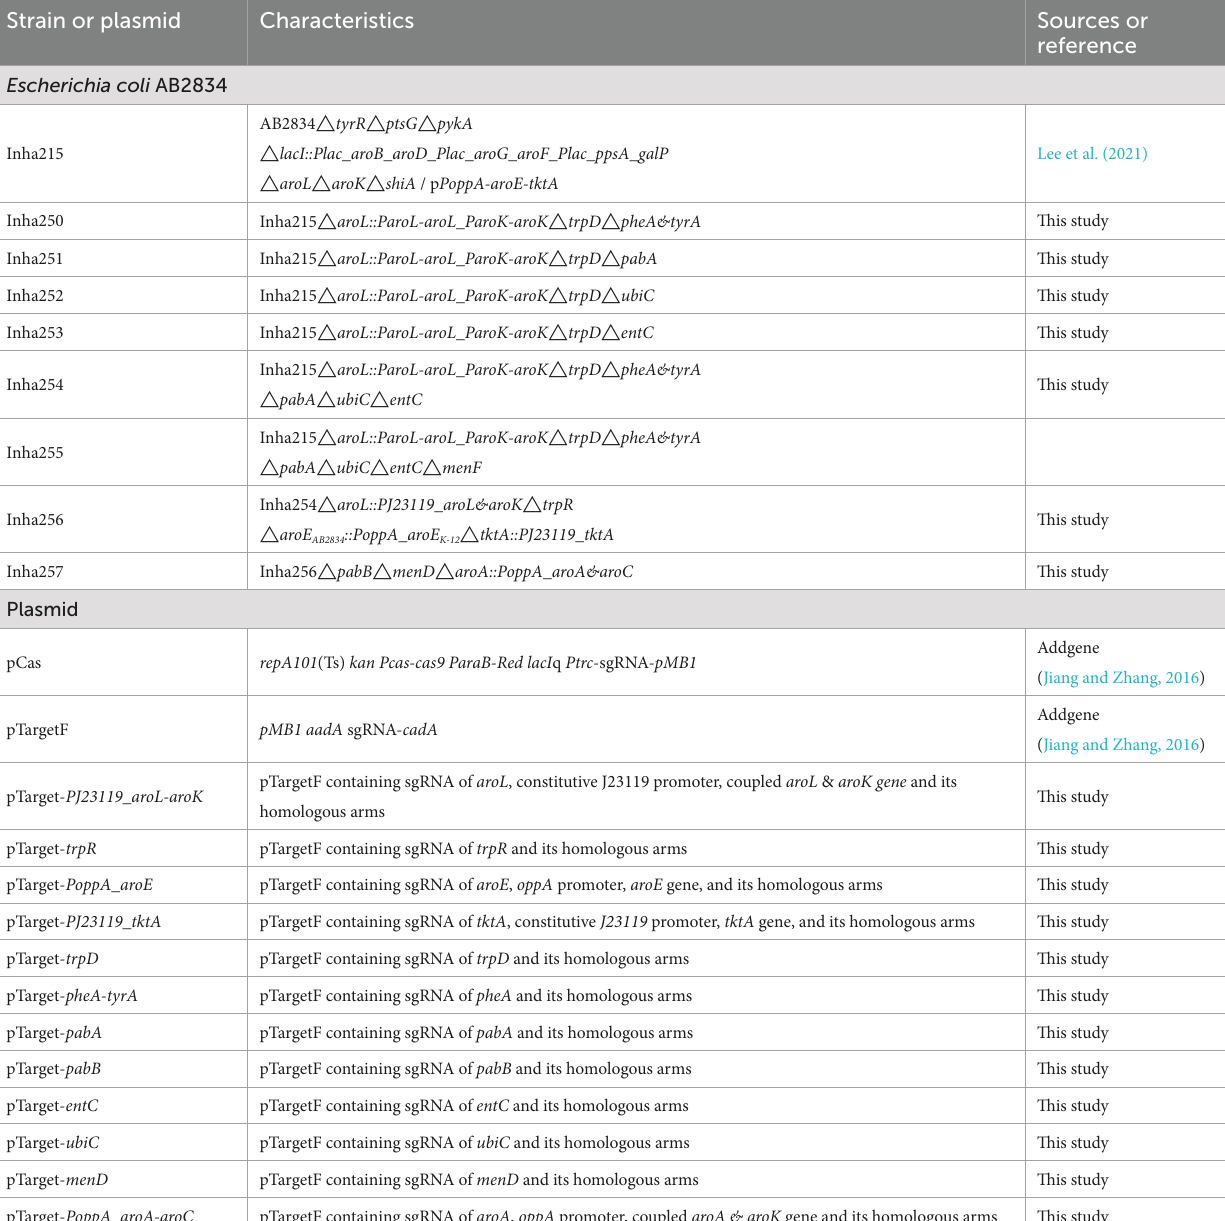
TABLE 1 Strains and plasmids used in this study. Strain or plasmid